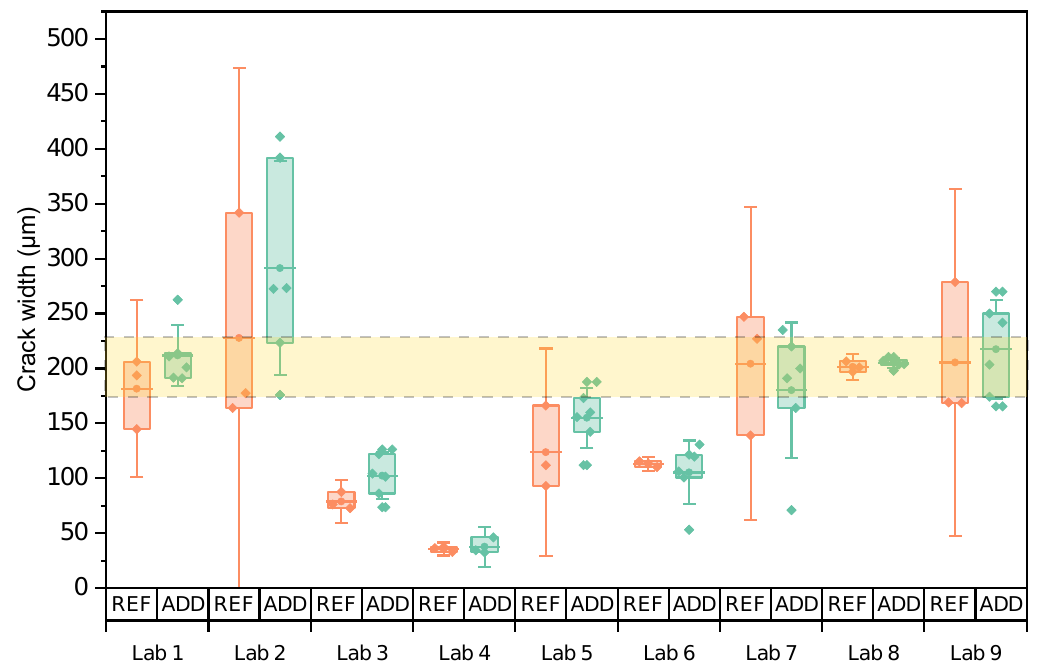
Figure 6. Crack width of individual prism specimens for which the mean of the series is indicated by horizontal lines and error bars give the 95% confidence interval on this mean. The area between the two dotted lines indicates the desired crack width. Table 7. Mean and coefficient of variation CV for the measured crack width of prism specimens, as well as the p -value for the statistical test comparing the mean to the target crack width of 200 µm, and the p -value for the test comparing the mean of the REF to the mean of the ADD. Batch